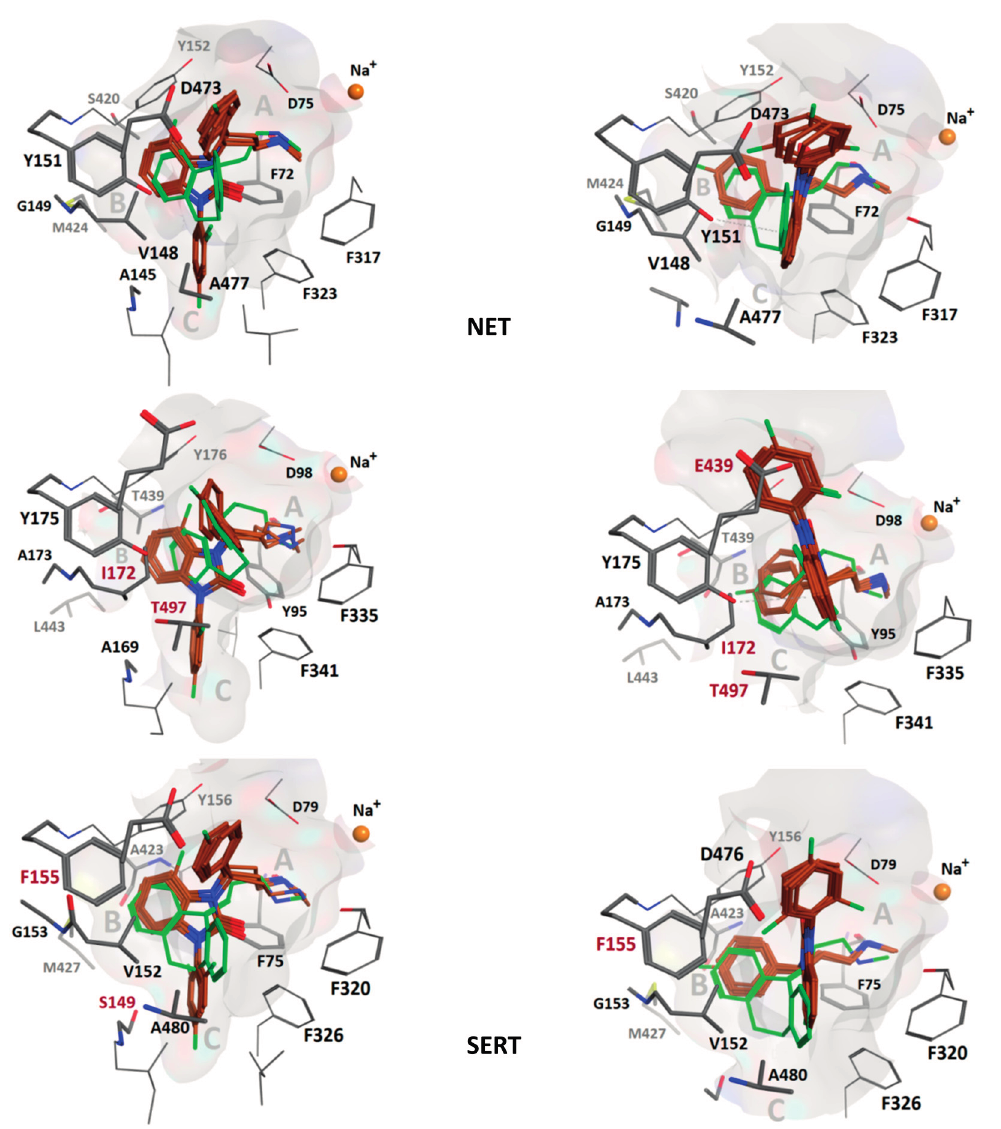
Figure 5. Left column : Overlay of compounds 1 , 2 , and 4 – 6 (maroon) in binding hypothesis 1 and comparison with the co-crystal pose of nortriptyline ( 31 ) (green). In NET, V148 allows more space than I172 in SERT. The angle between ligand ring 2 and 3 is ca. 60° in all poses. Right column : Overlay of compounds 1 , 2 , and 4 – 6 (maroon) in binding hypothesis 2. In NET, V148 still allows more space than in hSERT, whereas E439 might disrupt ligand ring 3. DAT lacks a more potent stacking interaction due to F155 as compared to NET[Y151] and SERT[Y175]. Binding mode 2 poses are more in agreement with the co-crystal pose. The angle between ligand ring 2 and 3 is almost 90° in all poses. The extracellular space is located above in all